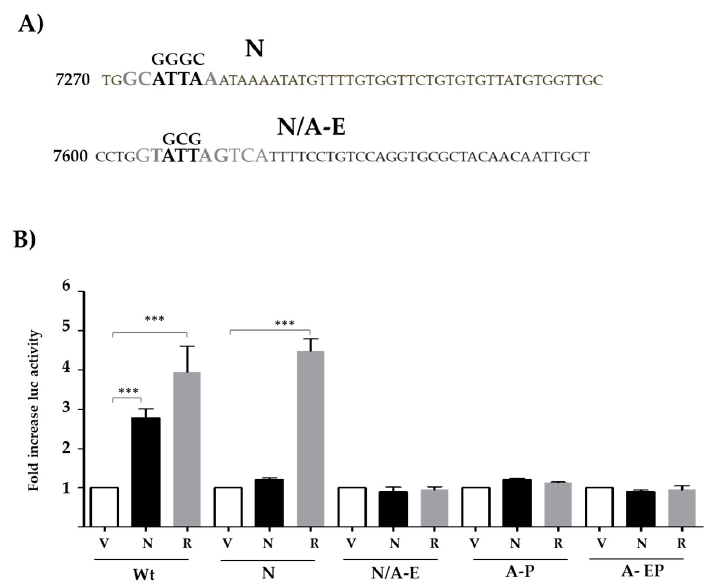
Figure 3. Mutations in Nanog- and AP1-putative-binding sites preclude the increase in HPV 18 LCR transcriptional activity mediated by Nanog. ( A ) Representation of Nanog sites on the HPV18 LCR (N & N/A-E) and mutations introduced (above). ( B ) Luciferase activity was evaluated in HEK-293T cells co-transfected with reporter vectors containing either wild type (Wt), mutations at Nanog site (N), Nanog-AP1 shared site (N/A-E), or single (A-P) or double mutants (A-EP) of AP1 sites, together with empty vector (V), Nanog (N), or H-Ras V12 (R) as a positive control. Luciferase activity was measured 48 h after transfection. The standard error of the mean of three independent experiments, in triplicate, is depicted. One-way ANOVA test with Tukey analysis was performed to evaluate the significant differences. *** p ≤ 0.001.